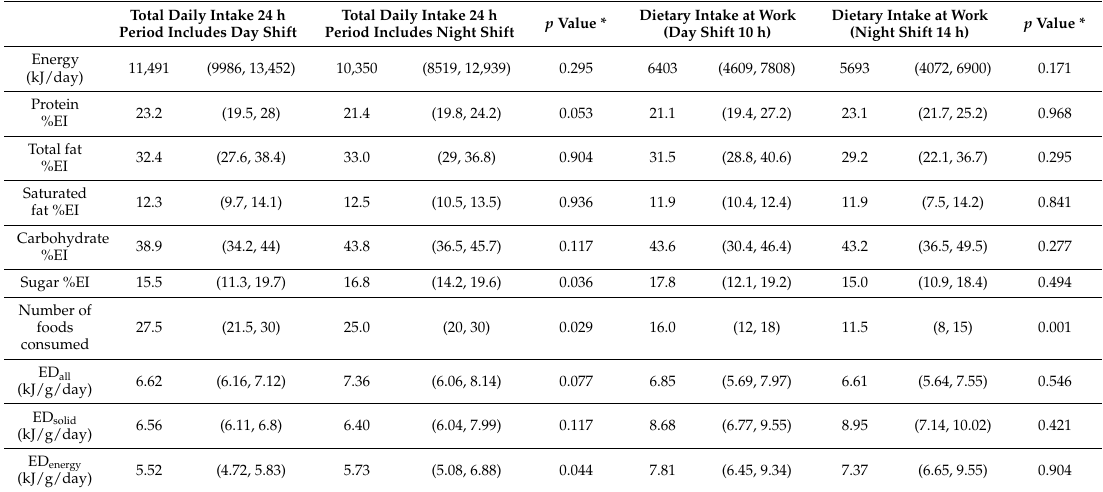
Table 4. Median dietary intake of shift workers ( n = 19) using 24 h dietary recalls. TotalDailyIntake24h TotalDailyIntake24h PeriodIncludesDayShift PeriodIncludesNightShift p Value*